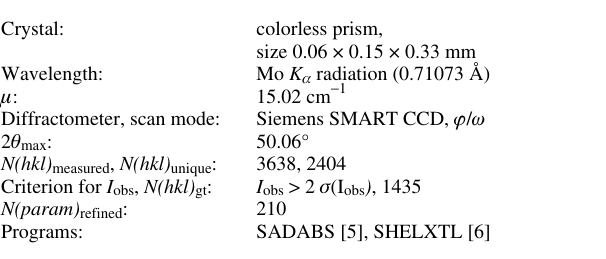
Table 2. Atomic coordinates and displacement parameters (in Å 2 ) . Atom Site Occ. U iso Crystal: